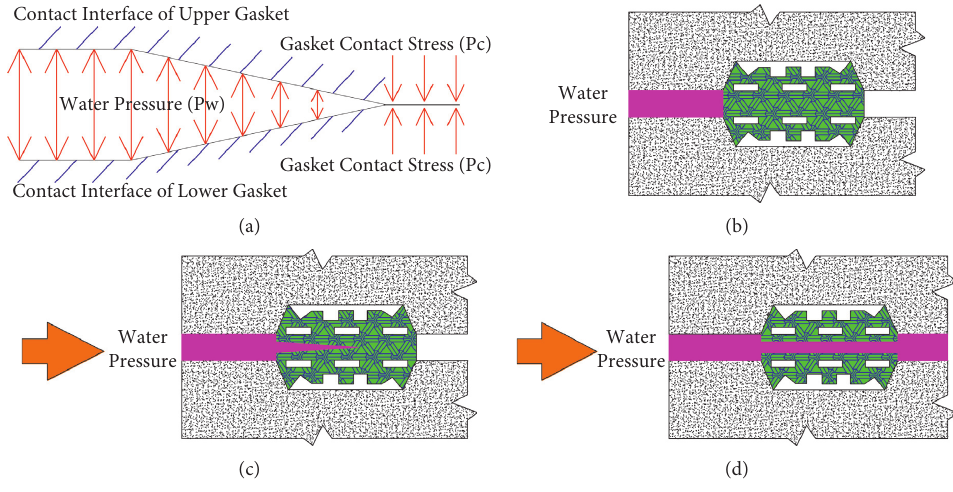
Figure 6: Water leakage process of lining joint. (a) Various loads on the gasket. (b) Initial penetration. (c) Further penetration. (d) Final leakage.